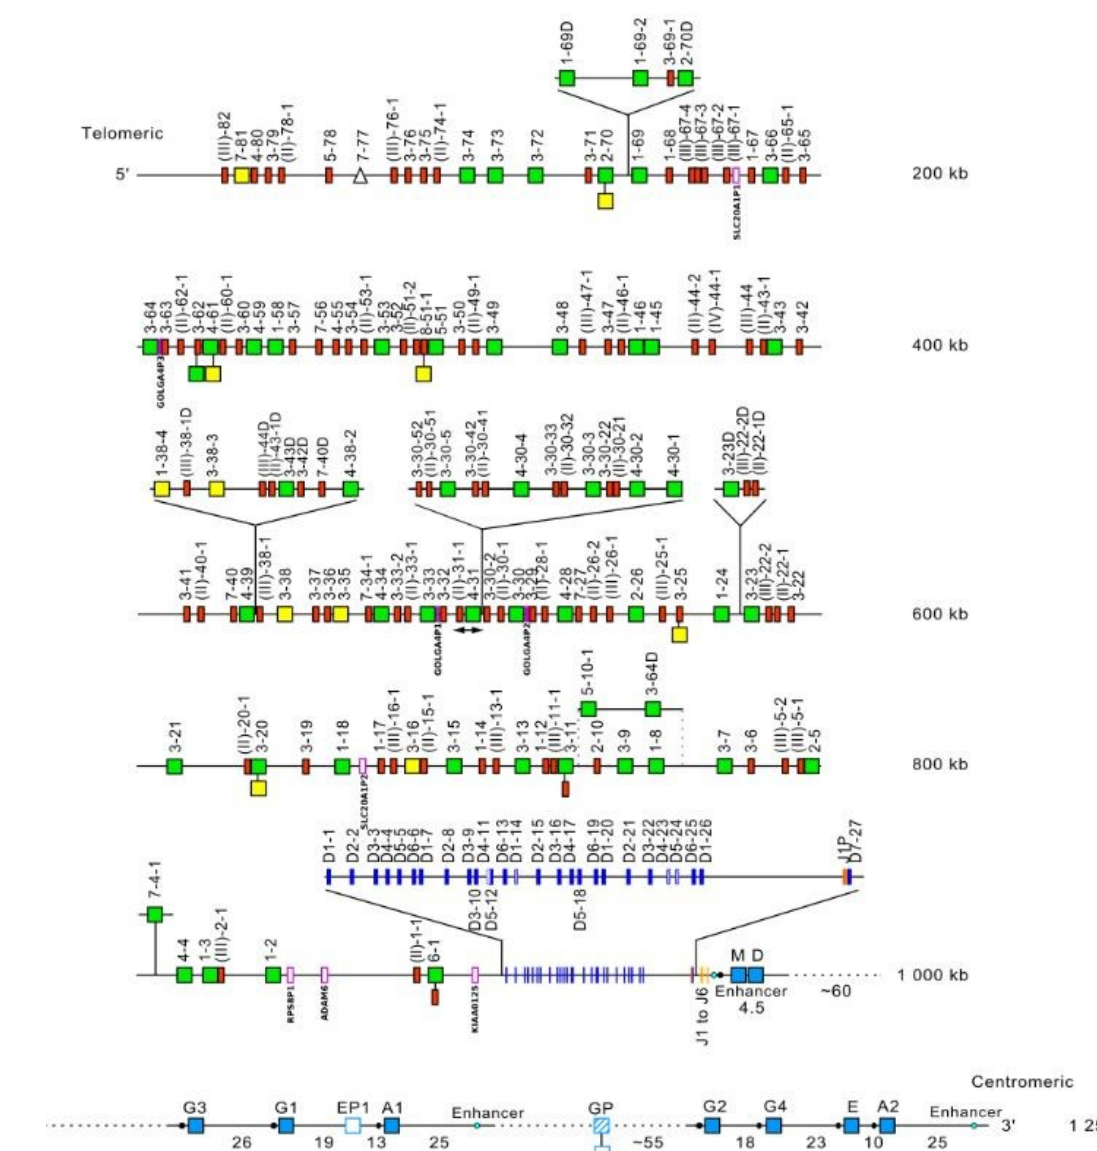
Figure 5. Representation of the human IGH locus at 14q32.33 (REV orientation on the chromosome) [2,5]. The boxes representing the genes are not to scale. Exons are not shown. Switch sequences are represented by a filled circle upstream of the IGHC genes. Pseudogenes that could not be assigned to subgroups with functional genes are designated by a Roman numeral between parentheses, corresponding to the clans, followed by a hyphen, and a number for the localization from 3 ′ to 5 ′ in the locus [2]. IMGT ® http://www.imgt.org (accessed on 20 February 2022), IMGT Repertoire